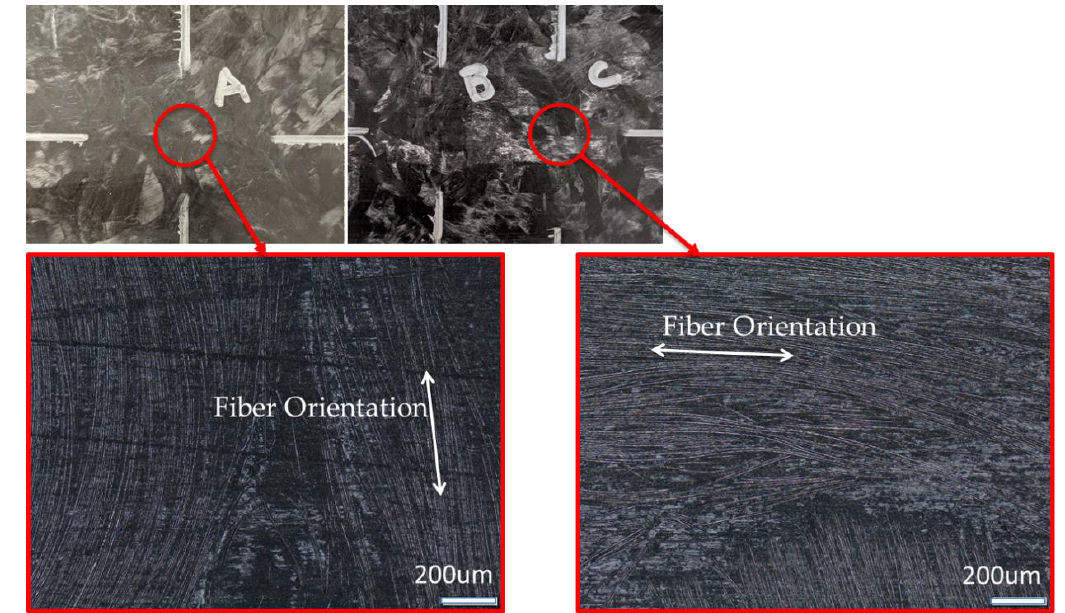
Figure 7. Local fiber orientation effects on thermal expansion of CFSMC (regions A and C from Figure 5b).